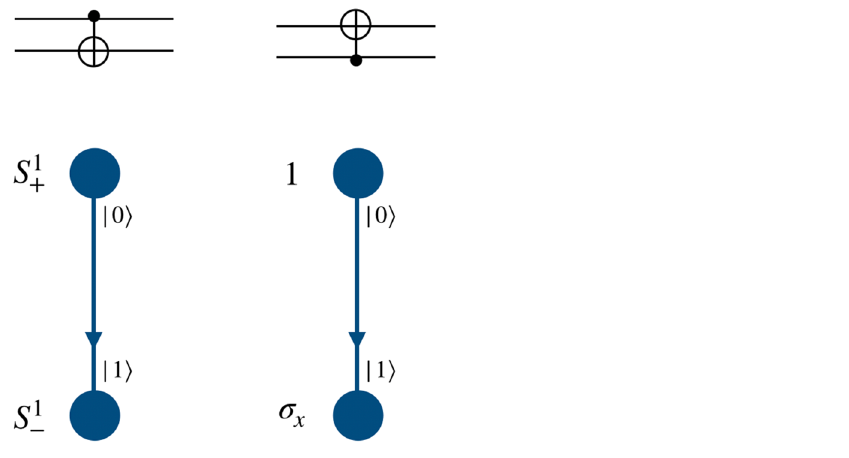
Figure 6. Schematic illustration of the controlled-NOT gate on the computational basis of two-qubit system using a single particle quantum walk on two point position space using position-dependent coin operation on 1 the real qubit. Form of the shift operator S is given in Eq. ±